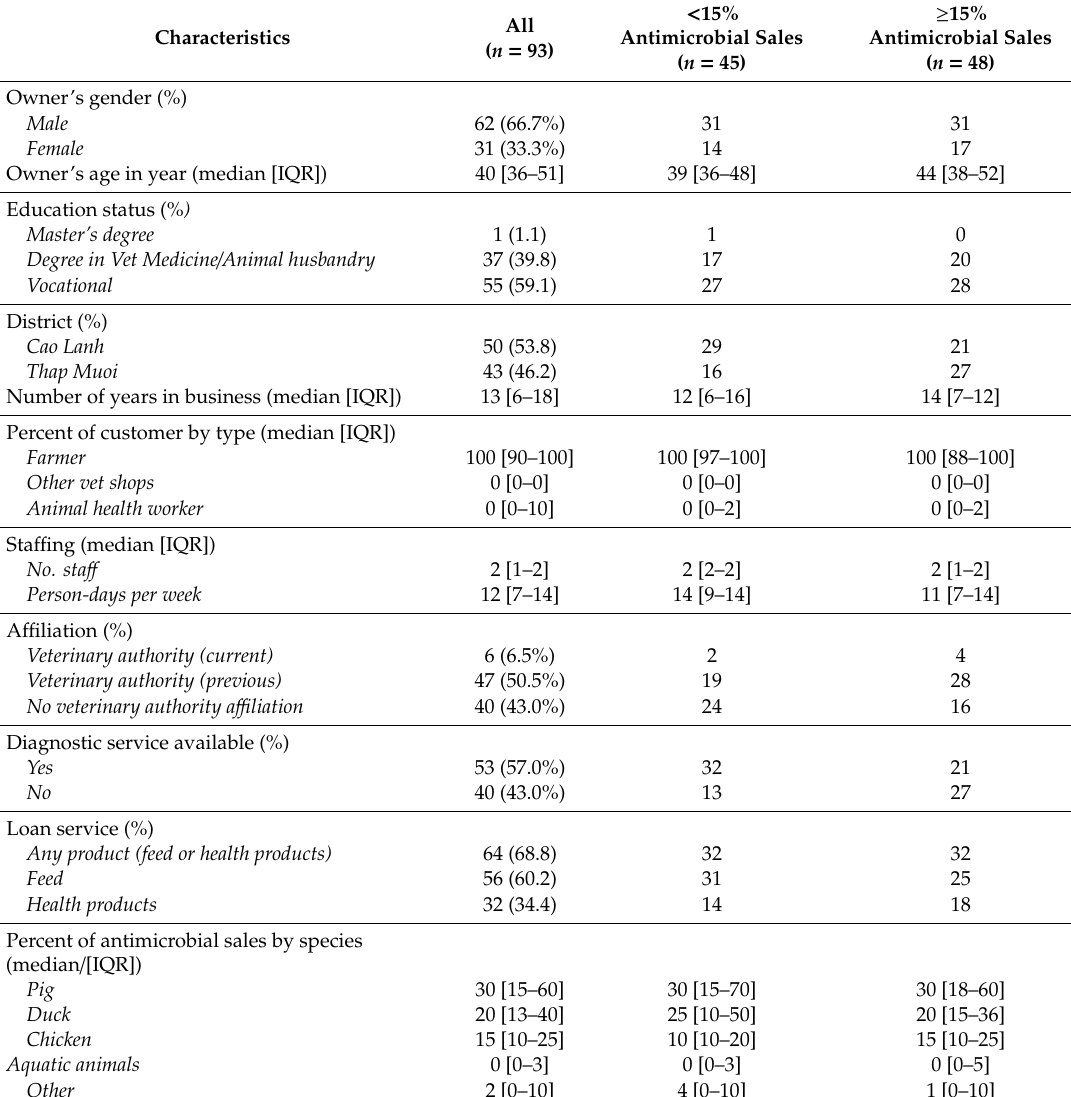
Table 1. Descriptive characteristics of veterinary drug shops. The breakdown of total sample size into a fraction of antimicrobial sales is based on a median of 15% of antimicrobial sales.